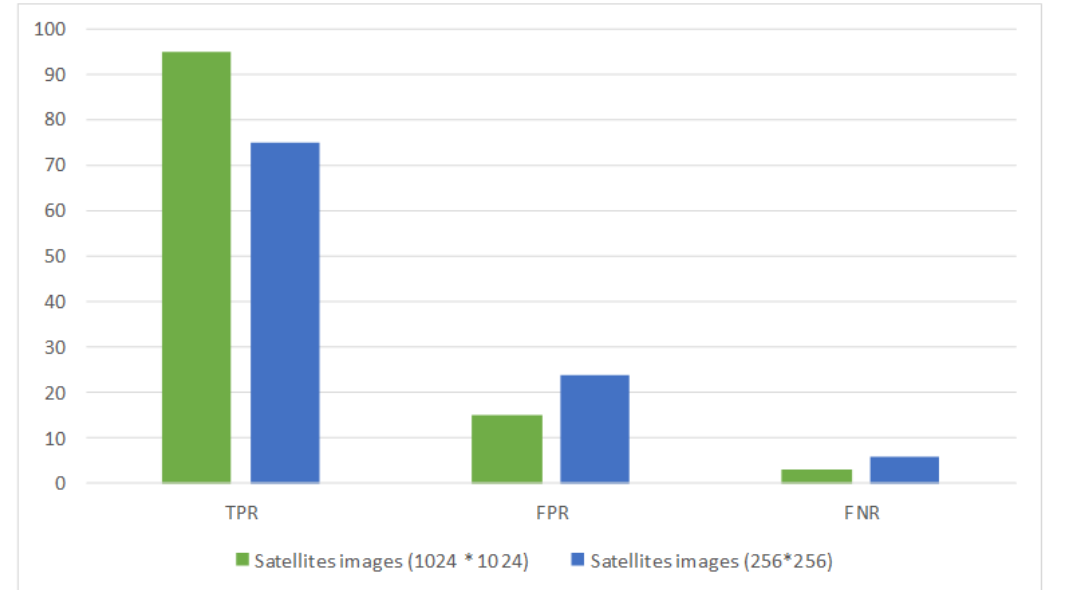
Figure 6: Left: Yolo test for Imagery with resolution (1024 × 1024). Right: Yolo test for Imagery with resolution (256 × 256 )